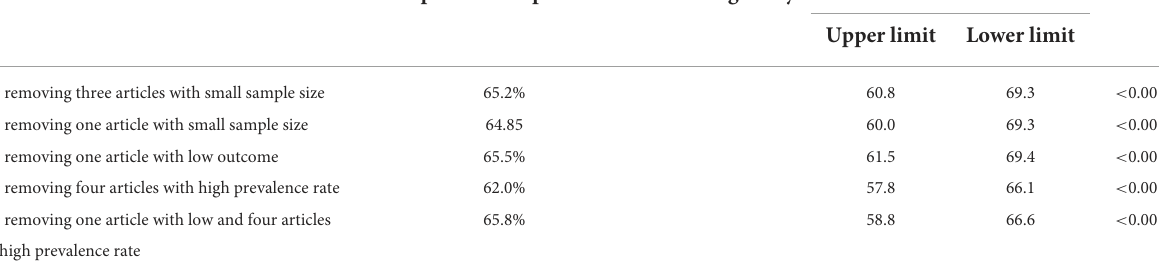
TABLE 1 Results of sensitivity analysis for COVID-19 vaccine acceptance,